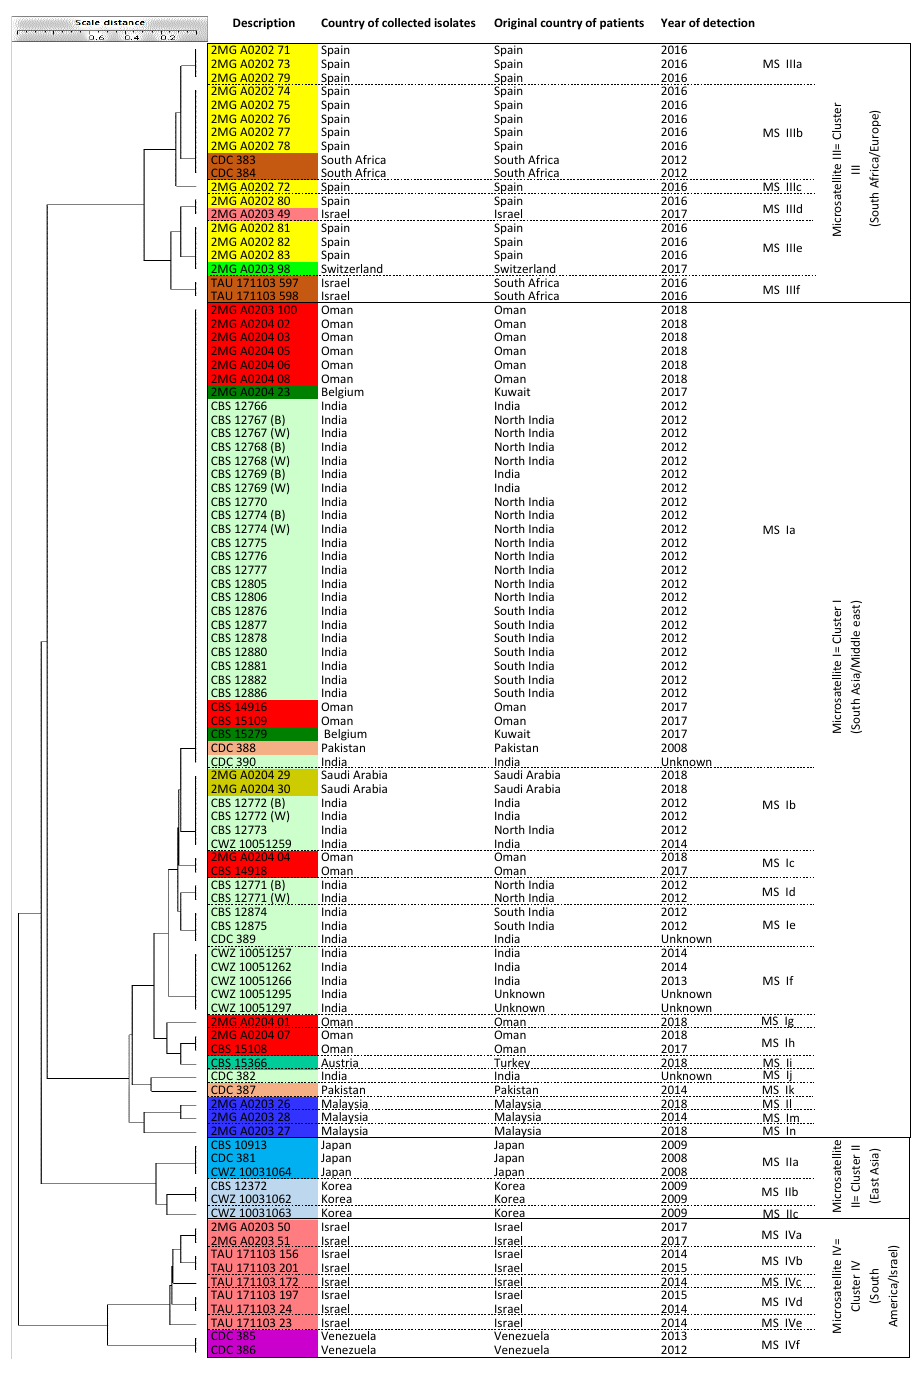
Figure 1. A UPGMA dendrogram was generated with BioloMICS v12 based on microsatellite analysis. Four main geographically linked clusters, namely South Asia / Middle East, East Asia, SouthAfrica / Europe, andSouthAmerica / Israelwerecreatedusing96isolates.Microsatelliteabbreviation (MS) was used for sub-clusters. The color coding used for this dendrogram was the same as follows: Austria (turquoise), Belgium (dark green), Japan (blue), India (light green), Israel (rose), Korea (light blue), Malaysia (dark blue), Oman (red), Pakistan (light pink), Saudi Arabia (chartreuse), Spain (yellow), South Africa (brown), Switzerland (green), and Venezuela